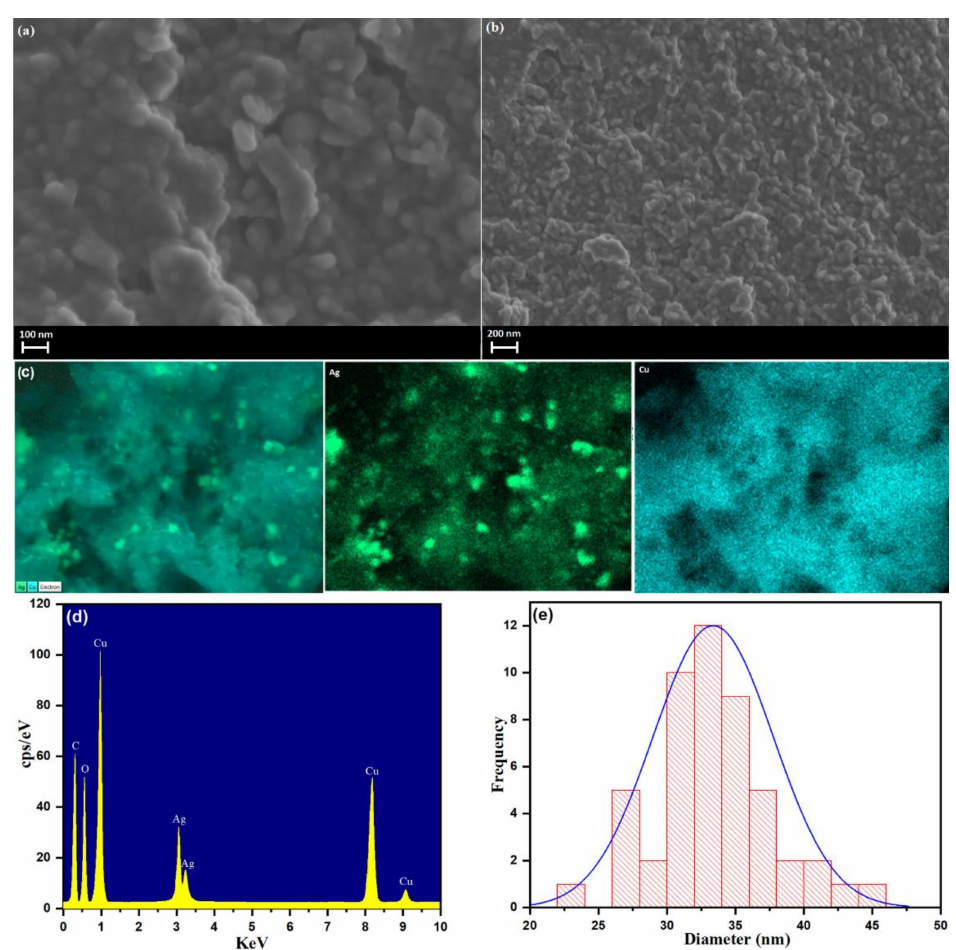
Figure 6. ( a , b ) Scanning electron microscope (SEM) images, ( c ) elemental mapping, ( d ) energy- dispersive X-ray spectra (EDX), and ( e ) particle size distribution of Ag-Cu bimetallic nanoparticles.